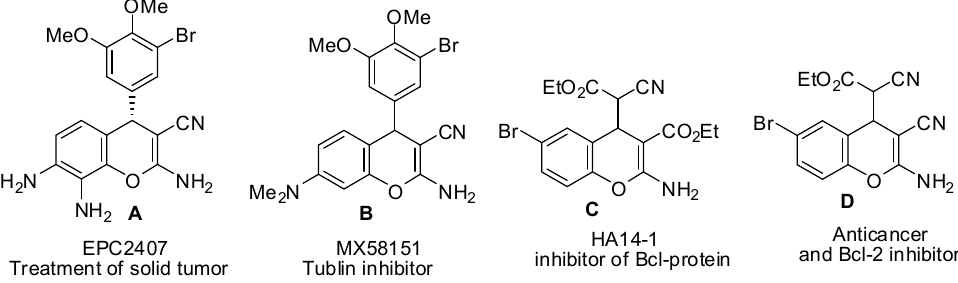
Figure 1. Structures of 2-amino-4 H -chromenes with diverse biological and pharmacological activities.